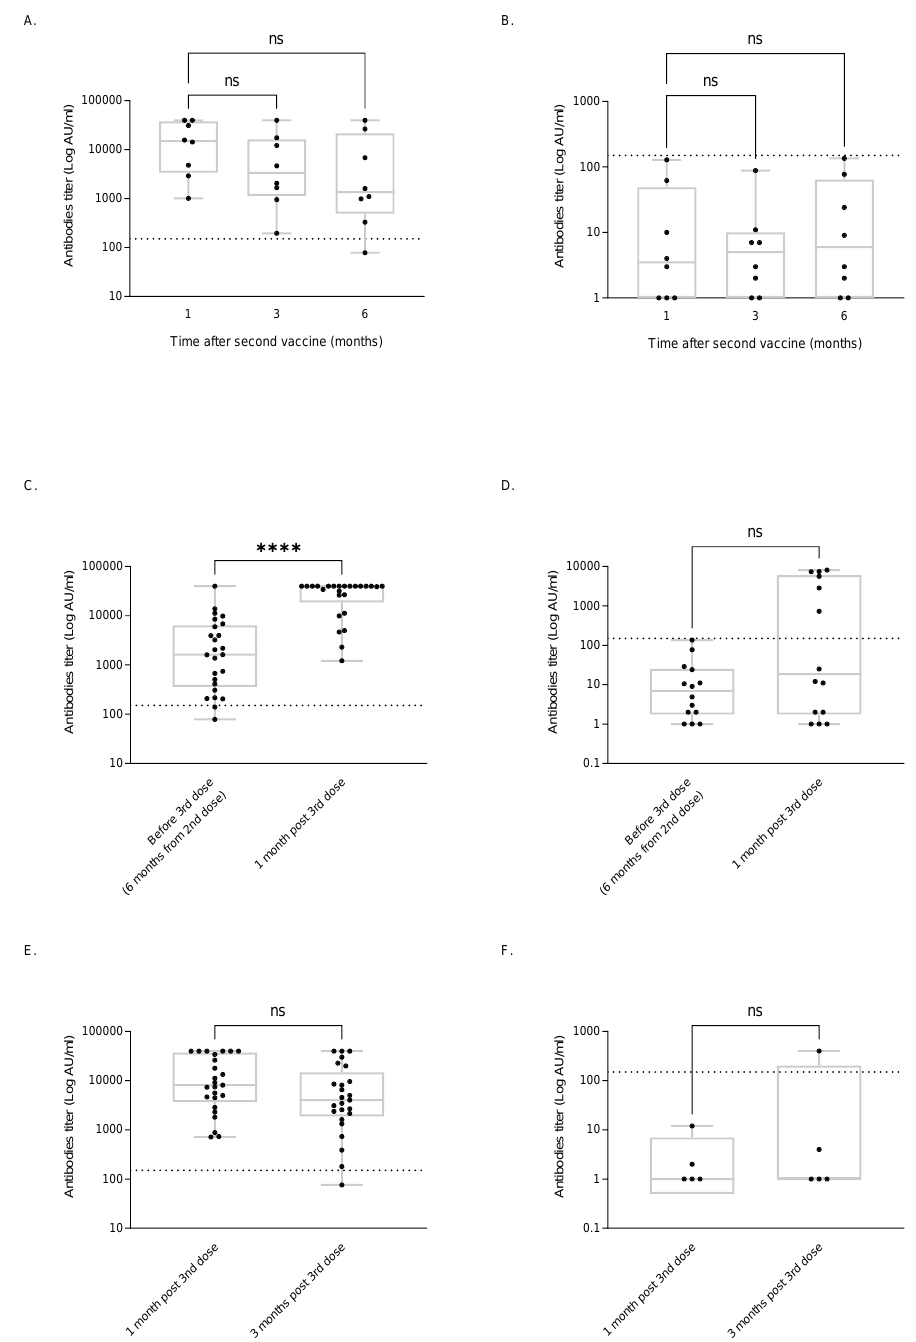
Figure 1. Antibody titer dynamics after the second and third vaccine doses in responders and non-responders. Antibody titer values are presented in Table S2. Titer dynamics after the second vaccine dose for responders, n = 8 ( A ) and non-responders, n = 8 ( B ). Antibody titers at 6 months from the second vaccination (before the third vaccine dose) and one month after the third vaccine dose in second dose responders, n = 25 ( C ) and non-responders, n = 14 ( D ). Antibody titer dynamics after the third vaccination in responders, n = 25 ( E ) and non-responders, n = 5 ( F ). **** p < 0.0001. ns — not significant.